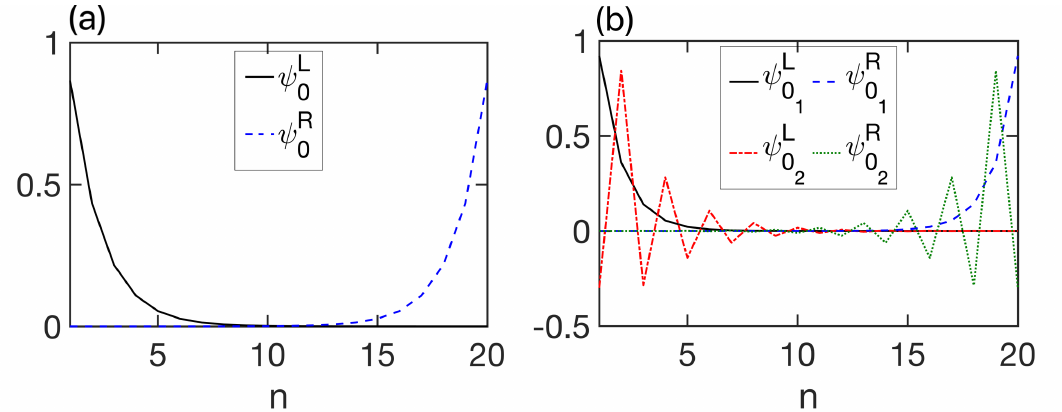
Figure 5: Behavior of the wave functions of the zero-energy end states (Majo- rana zero modes) for open spin chains with length N = 20. (a) ψ L and ψ R 0, n 0, n = 2 B and of the transverse Ising model in the topological regime g = 1 with J ( 1 ) x = J ( 2 ) = J ( 2 ) = 0. (b) ψ L J ( 1 ) , ψ R , ψ L , ψ R of the extended model in the y y x 0 1 , n 0 1 , n 0 2 , n 0 2 , n = 0.25 J ( 2 ) = J ( 2 ) = topological regime g = 2 with B = J ( 1 ) and J ( 1 ) x x y y